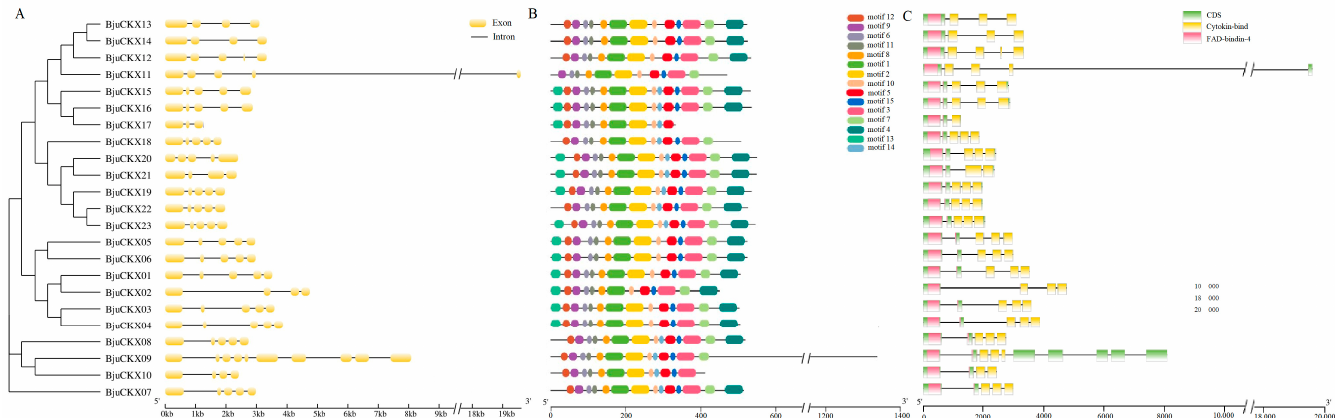
Figure 5. Gene structure analysis, motif structure, and conserved binding domain of CKX gene family members in B. juncea var. tumida . ( A ) BjuCKX gene structure map: Boxes and lines represent exons and introns, respectively. ( B ) Motif structure map: The 15 motifs were identified using MEME program, with each number of colored boxes representing a different motif. ( C ) BjuCKX conserved binding domain map: Colored boxes of different colors represent different conserved